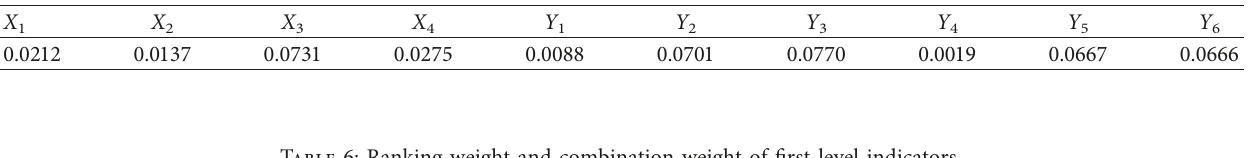
Table 5: Consistency test of first-level elements with decision objectives (CR <